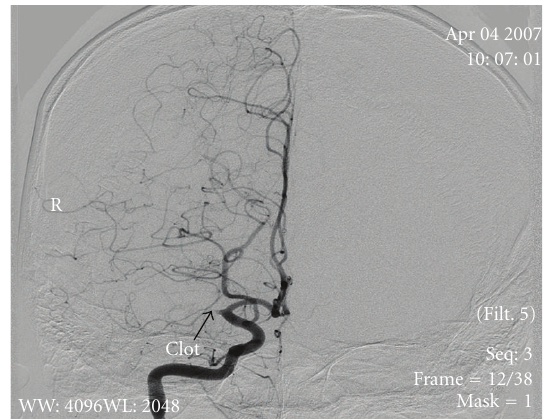
Figure 1: Di ff usion weighted imaging (DWI) showing area of restricted di ff usion.